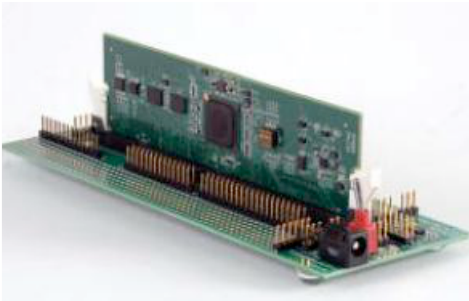
Figure 9: The F28335 controlCard [13] Figure 12. The F28335 controlCard [7].